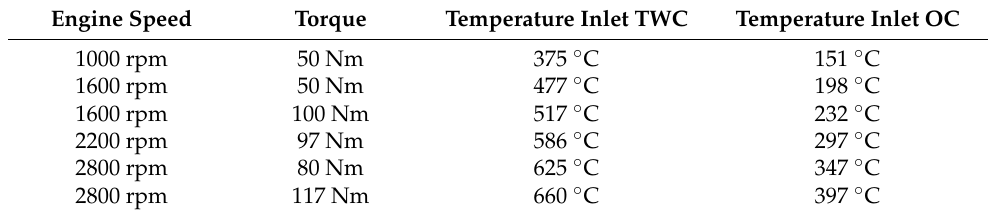
Table 7. Engine operating points with the corresponding temperature at the inlet of the TWC and OC.